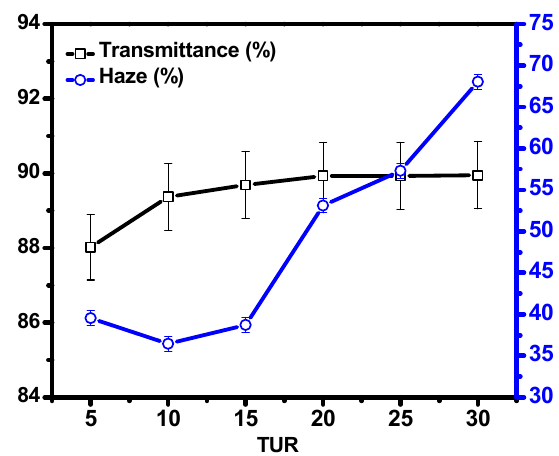
Figure 3. Haze and transmittance of PE / EMAA films at various TURs.